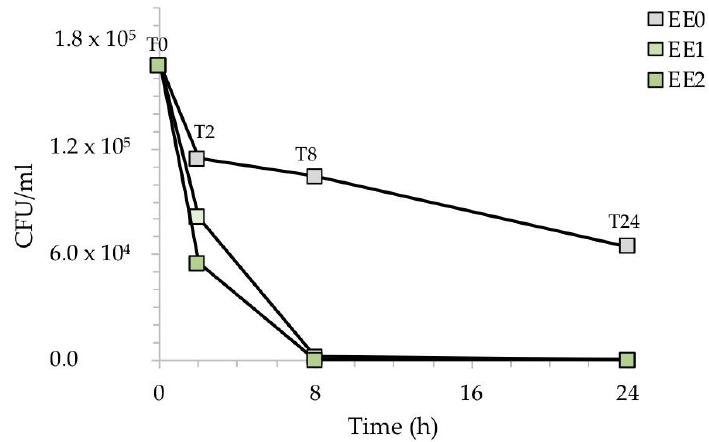
Figure 5. CFU/mL recovered after the exposure of the silver-treated contaminated surfaces to E. coli with respect to the untreated control. The results are representative of three independent determinations.